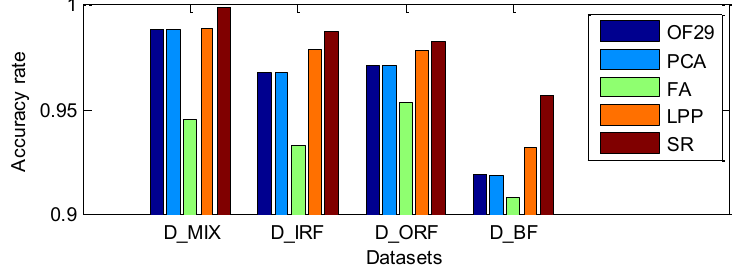
Figure 17. The comparison of the accuracy rate in four